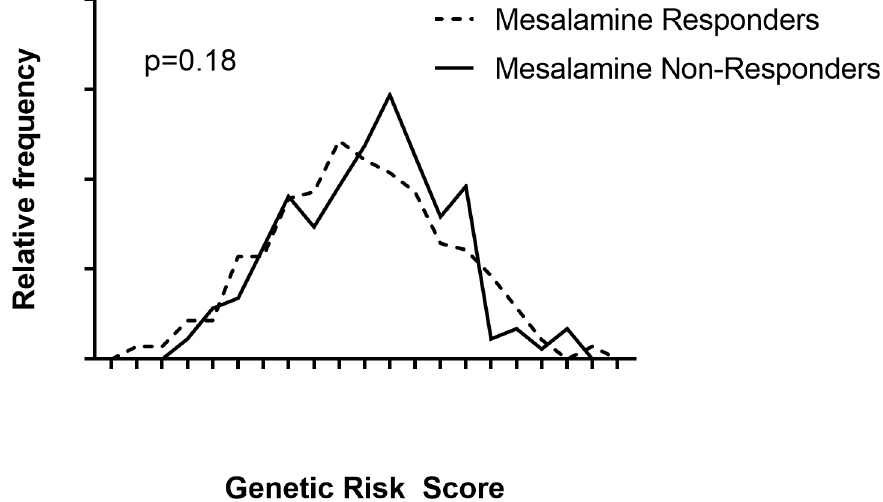
Fig 1. Genetic risk score distribution. Histogram of the genetic risk scores (GRS) of mesalamine responders (dashed line) and mesalamine non-responders (solid line). GRS was calculated by summation of the log of the odds ratio at each of 133 ulcerative colitis risk SNPs multiplied by number of risk alleles in each patient.